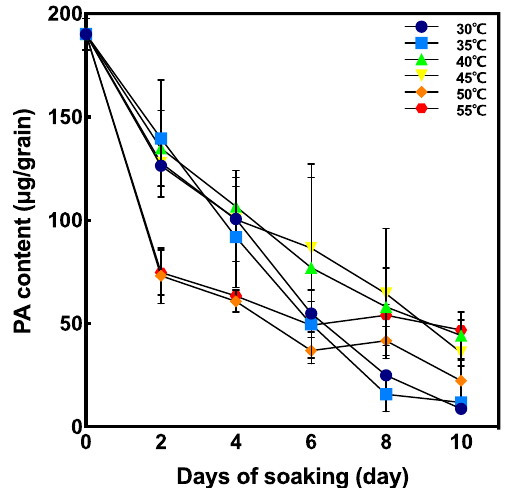
Figure 4. Effect of soaking temperature on phytic acid (PA) content in germinated brown rice (GBR). Data are shown as the mean ± standard deviation of 3–5 replicates.